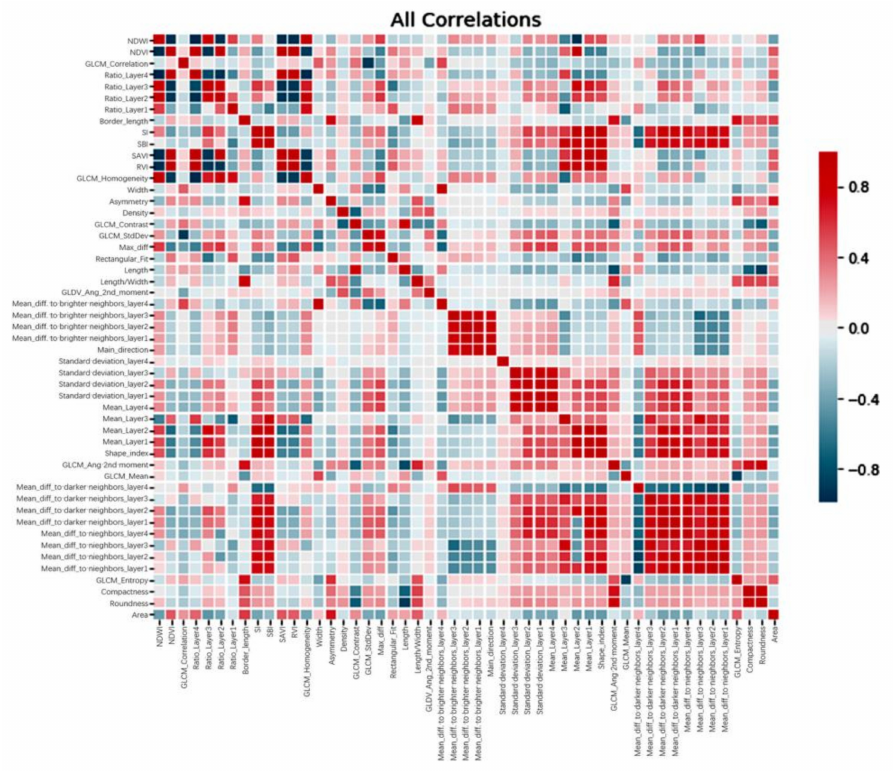
Figure 6. Thermodynamic chart of the remaining 51 features.